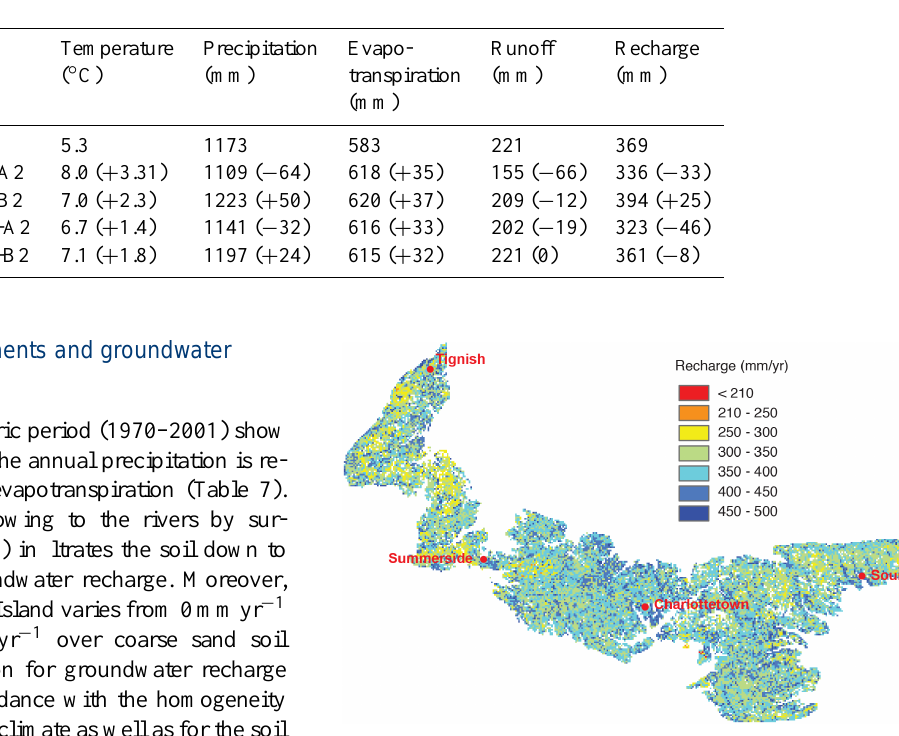
Figure 4. Spatial distribution of groundwater recharge from